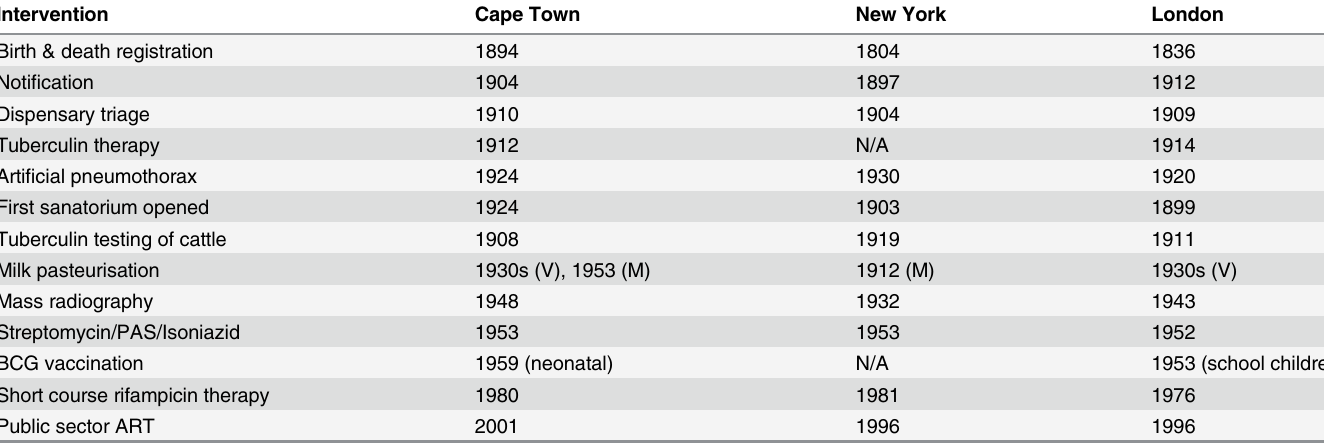
Table 1. Timeline of implementation of TB control interventions in Cape Town, New York and London. Data from [2, 9, 16, 25 –